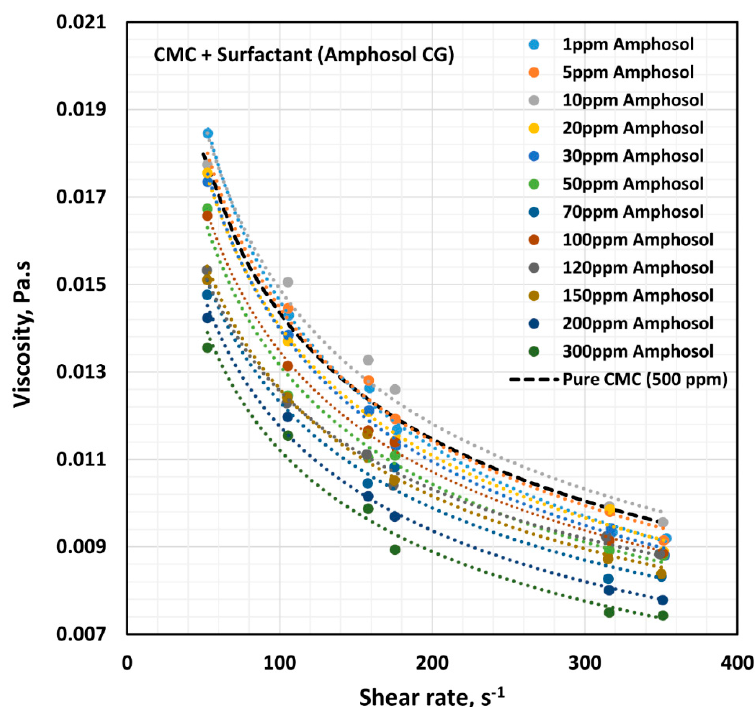
Figure 17. Effect of zwitterionic surfactant (Amphosol CG) on the viscosity versus shear rate behavior of solutions of mixtures of anionic polymer, CMC, and zwitterionic surfactant, Amphosol CG, at a fixed polymer concentration of 500 ppm.